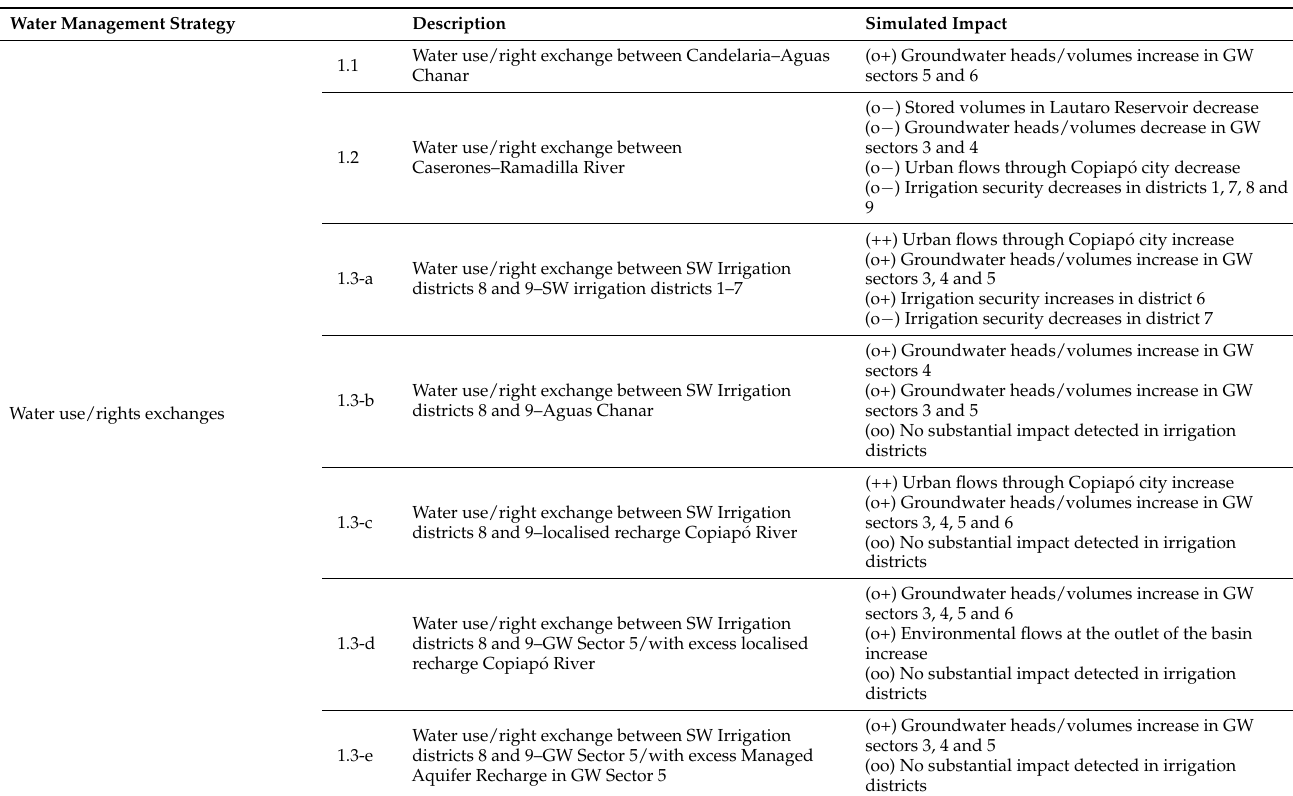
Figure A1. Graphical user interface for SimCopiapo platform v1.0 (in Spanish). Table A1. Summary of impacts for water management strategies implemented in